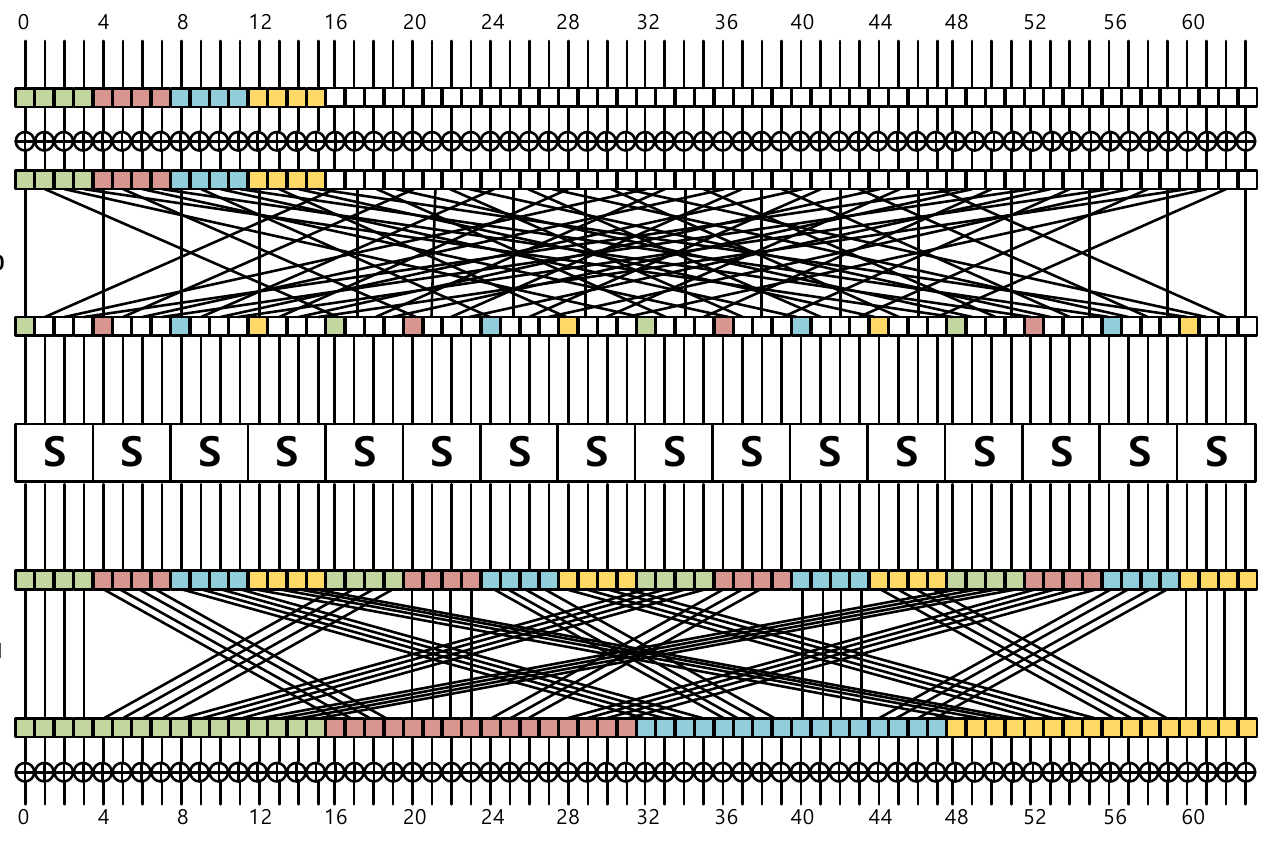
Figure 1. PRESENT-CTR with 16-bit